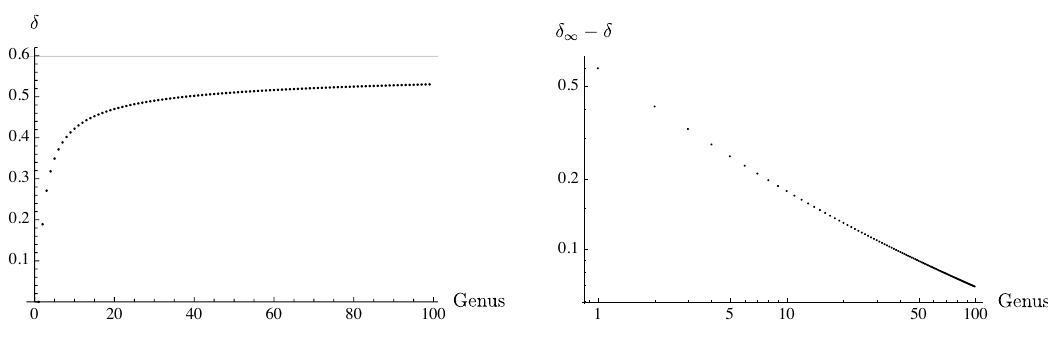
Figure 5. The critical dimension for the x = 1 The asymptote is the computed limit as n ! 1 . On the right is a log-log plot showing convergence to this